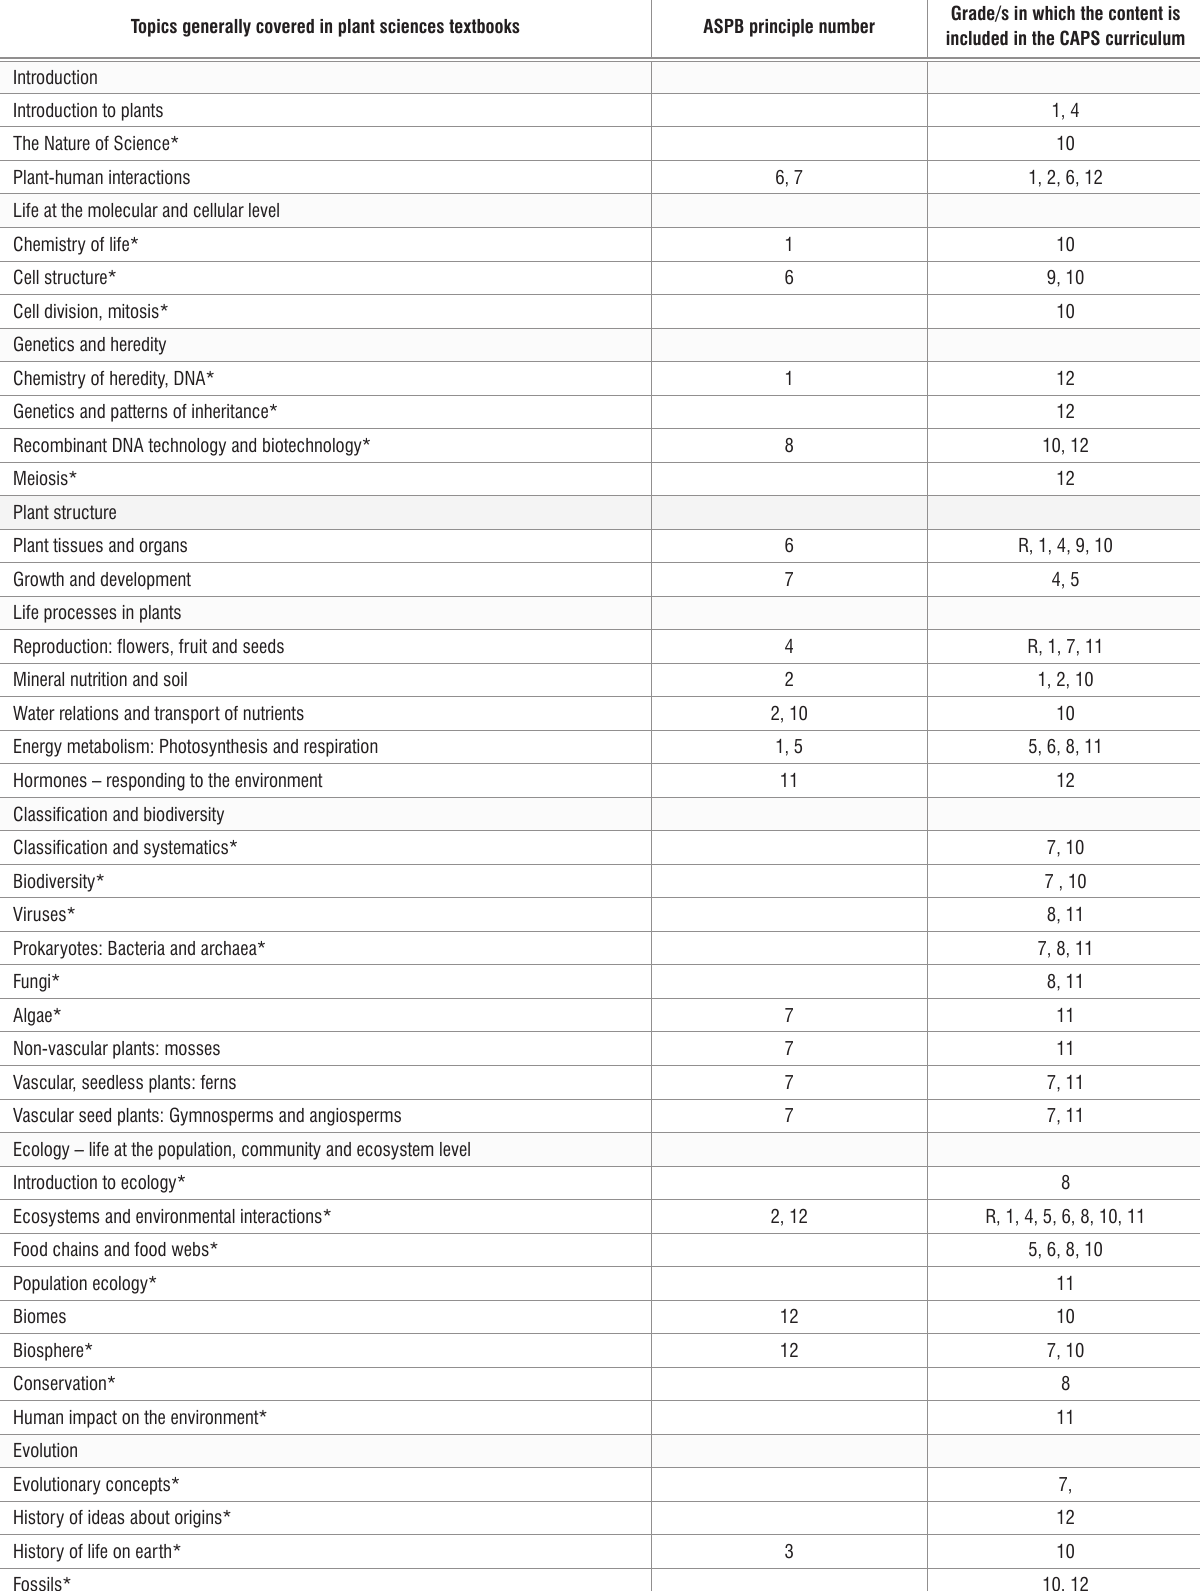
Table 2: List of the topics in the Curriculum and Assessment Policy Statements (CAPS) curricula for Grades R–12 10-13 that are included in botany textbooks, including those by Mauseth 25 , Evert and Eichhorn 26 , Stern et al. 27 and Uno et al. 28 The American Society of Plant Biologists (ASPB) 23 principles listed in Table 1 that correspond to these topics are shown in the second column. It should be noted that not all the ASPB topics are covered in detail. Topics generally covered in plant sciences textbooks ASPB principle number